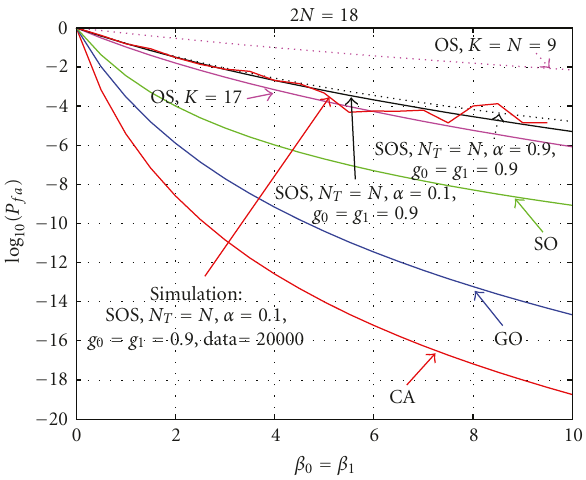
Figure 4: False alarm probability of the SOS CFAR I processor for di ff erent β 0 = β 1 in terms of α